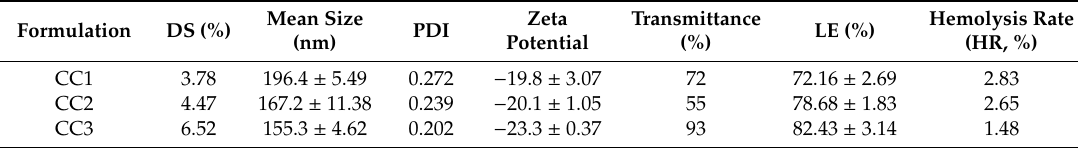
Table 1. General properties of CC conjugates and CC-NPs. DS: degree of substitution, LE: loading efficiency, PDI: polydispersity.